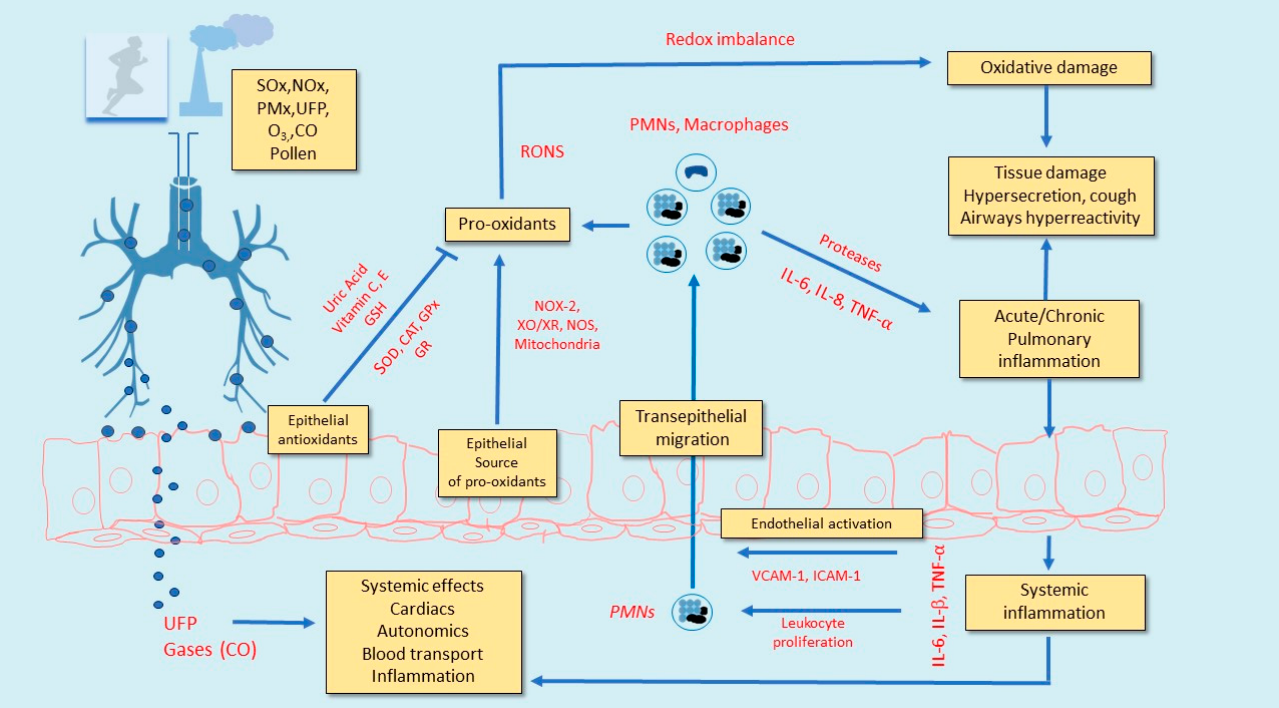
Figure 1. Systemic and localized effects at the lung level generated by air pollutants. SOx = sulphur oxides; NOx = nitrogen oxides; PMx = particulate matter; UFP = ultrafine particles; SOD = superoxide dismutase; CAT = catalase; GPx = glutathione peroxidase; GR = glutathione reductase; GSH = reduced glutathione RONS = reactive oxygen and nitrogen free radicals; NOX-2 = NADPH oxidase type 2; XO = xanthine oxidase; XR = xanthine reductase; NOS = nitric oxide synthase; PMNs = polymorphonuclear leukocytes. VCAM-1 = vascular cell adhesion molecule 1; ICAM-1 = intercellular adhesion molecule 1.